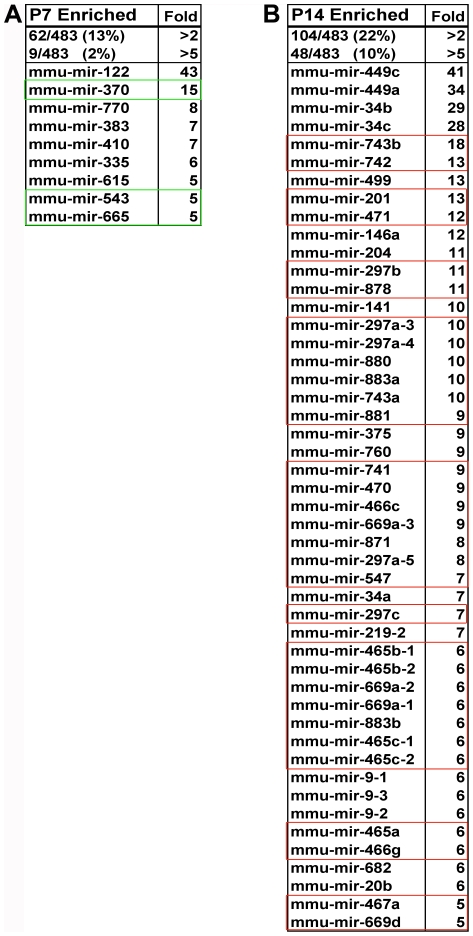
MicroRNAs with the most dramatic enrichment are associated with chromosomes 2, 12, and X.Roughly 2% of miRNAs were enriched more than five-fold at P7 (left). Of these miR-122 was the most enriched (43-fold). By contrast, nearly 10% of miRNAs were enriched to the same degree at P14 (right). The most enriched was miR-449c (41-fold). A number of miRNAs most induced at P7 are located on chromsome 12 (boxed in green) while those most induced at P14 cluster on chromosomes 2 and X (boxed in red).